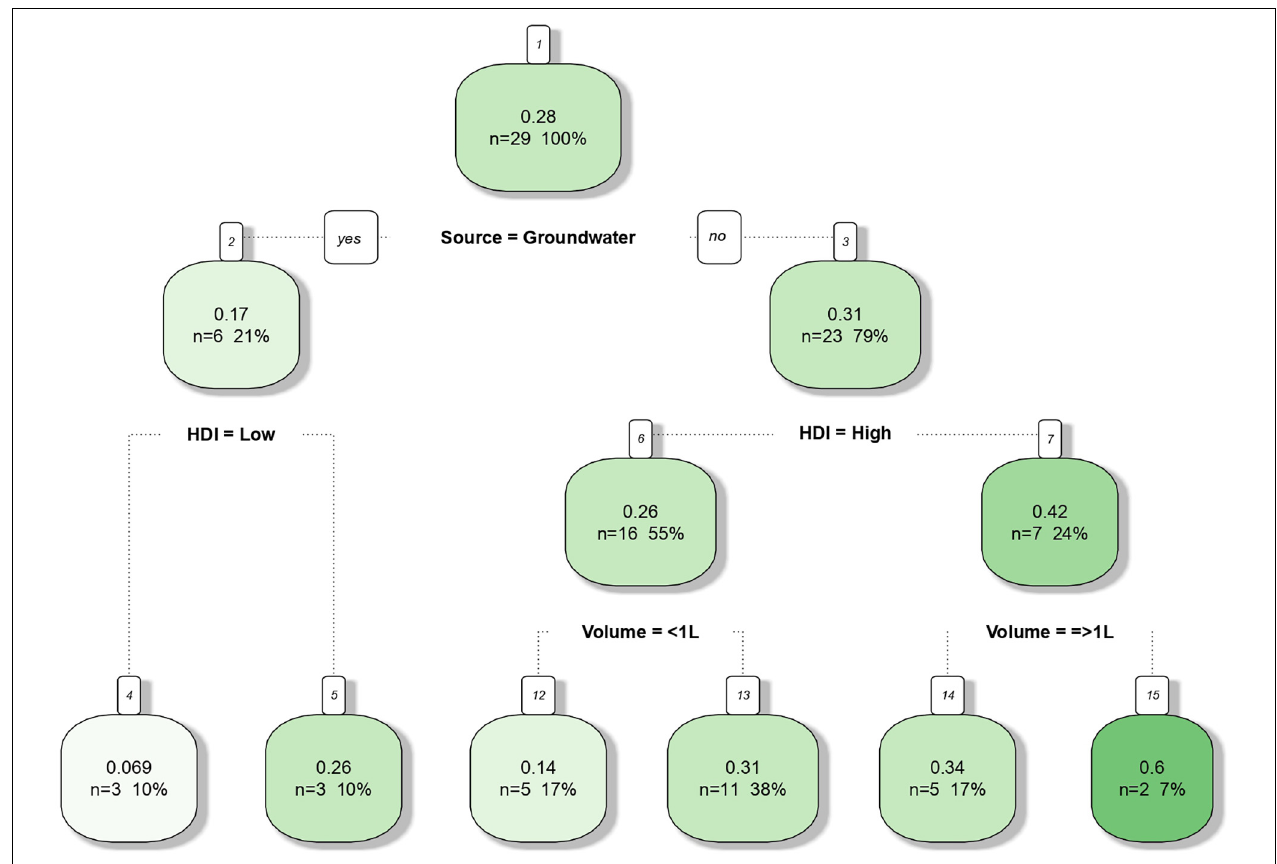
FIGURE 4 | Decision tree predicting the frequency of Salmonella in non-recycled water sources in function of the moderator variables source (surface or groundwater), human development index (HDI) of the country from which the samples originated (high or low) and water sample volume ( < 1 L or ≥ 1 L). The predictive algorithm has been built in R (package rpart) using meta-analysis data of 26 peer reviewed scientific publications between the years 2015 and 2020.